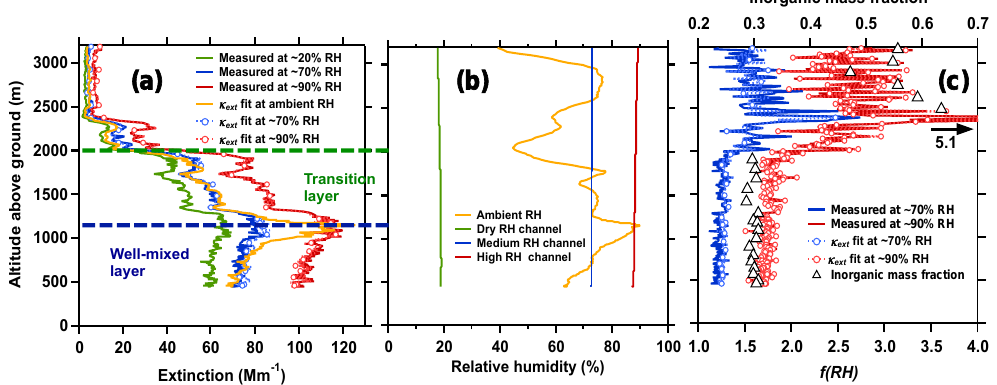
Figure 3. A vertical profile measured from 18:29 to 18:35UTC on 22 June 2013 over east-central Alabama. (a) Extinction measured in the dry, medium-, and high-RH channels of the CRDS, extinction calculated using the fitting method described in Sect. 3.4, and extinction at ambient RH calculated using this method. The dashed horizontal lines show the boundaries between the well-mixed and transition layers and between the transition layer and free troposphere, as defined by Wagner et al. (2015). (b) Measured RH values within the dry, medium-, and high-RH channels of the CRDS, and ambient RH. (c) f (RH) measured at the medium and high RH conditions, and calculated from fitted values as in (a) . Circles show the f (RH) values from fitting Eq. (6) to the f (RH) data. Triangles show the fraction of sub-0.7µm aerosol mass measured by the AMS that is inorganic (top